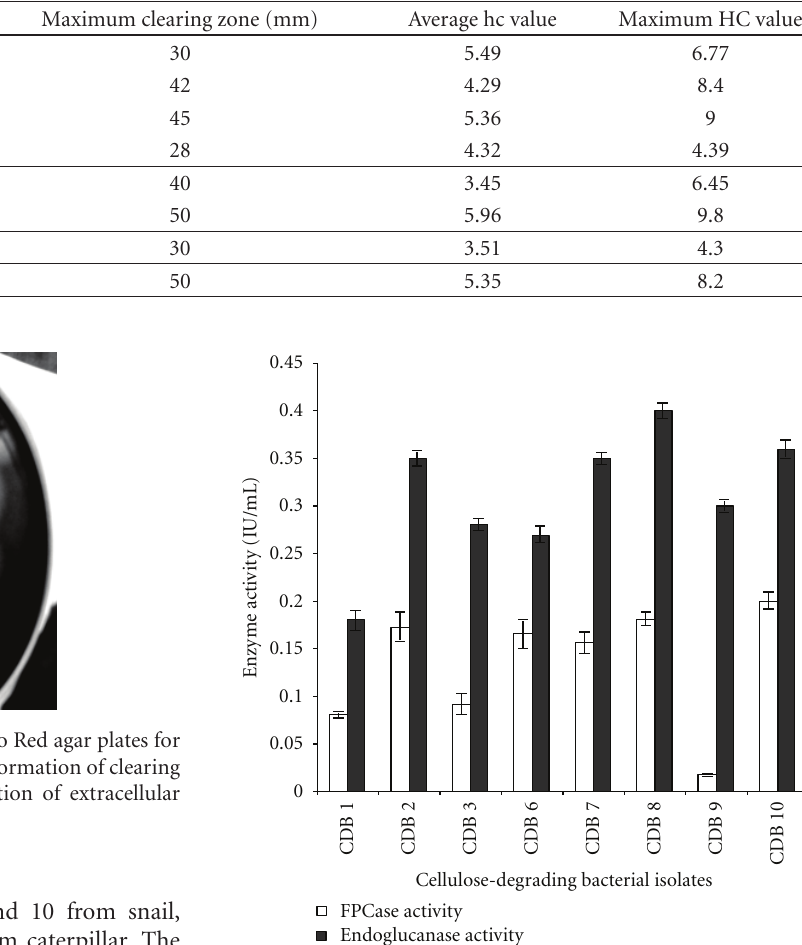
Table 1: Maximum clearing zone and hydrolytic capacity (HC) value of CDB on cellulose Congo red agar media. This table shows the assessment of bacterial isolates from the di ff erent source organism for cellulose decomposition via measurement of clear zone around the colony and calculation of hydrolytic value in cellulose Congo Red media. Maximum clearing zone of 50 mm and HC value of 9.8 were estimated for CDB 10.